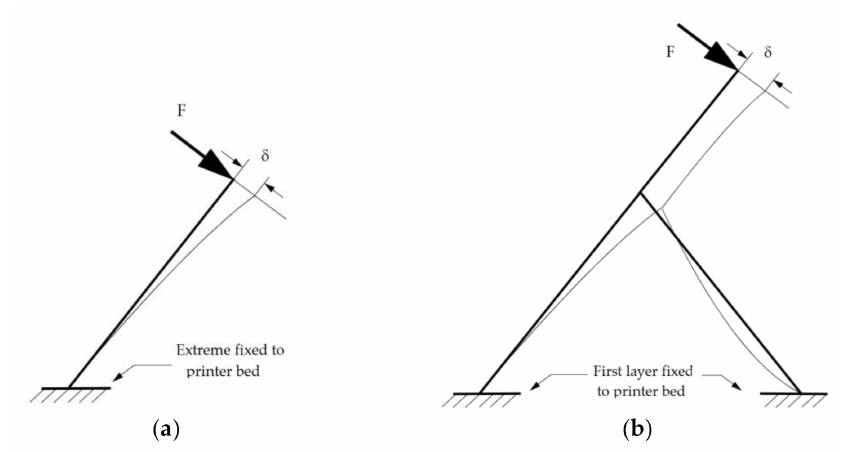
Figure 9. Influence of strut position on its deflection ( δ ); ( a ) deflection in slender struts fixed directly to the printer bed is determined by strut geometry; ( b ) deflection of struts connected to nodes (upper rows) depends on both strut geometry and stability of the lattice.